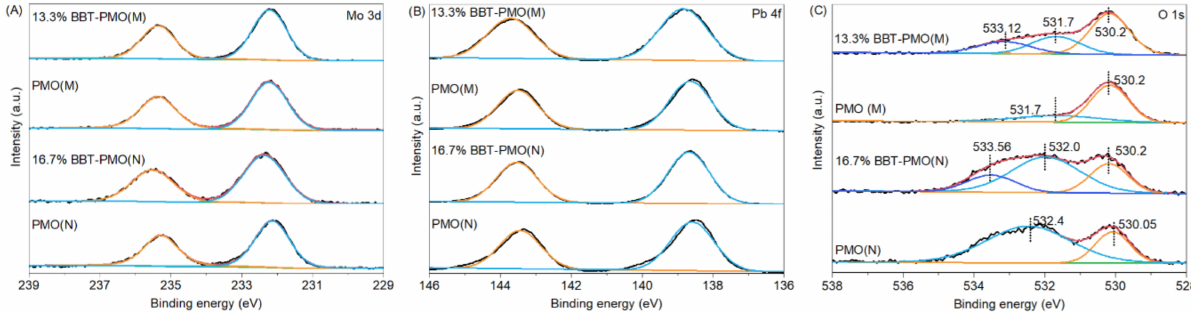
Figure 8. XPS spectra of ( A ) Mo 3d, ( B ) Pb 4f, and ( C ) O 1s in PMO(M), 13.3% BBT-PMO(M) and PMO(N) and 16.7% BBT-PMO(N).